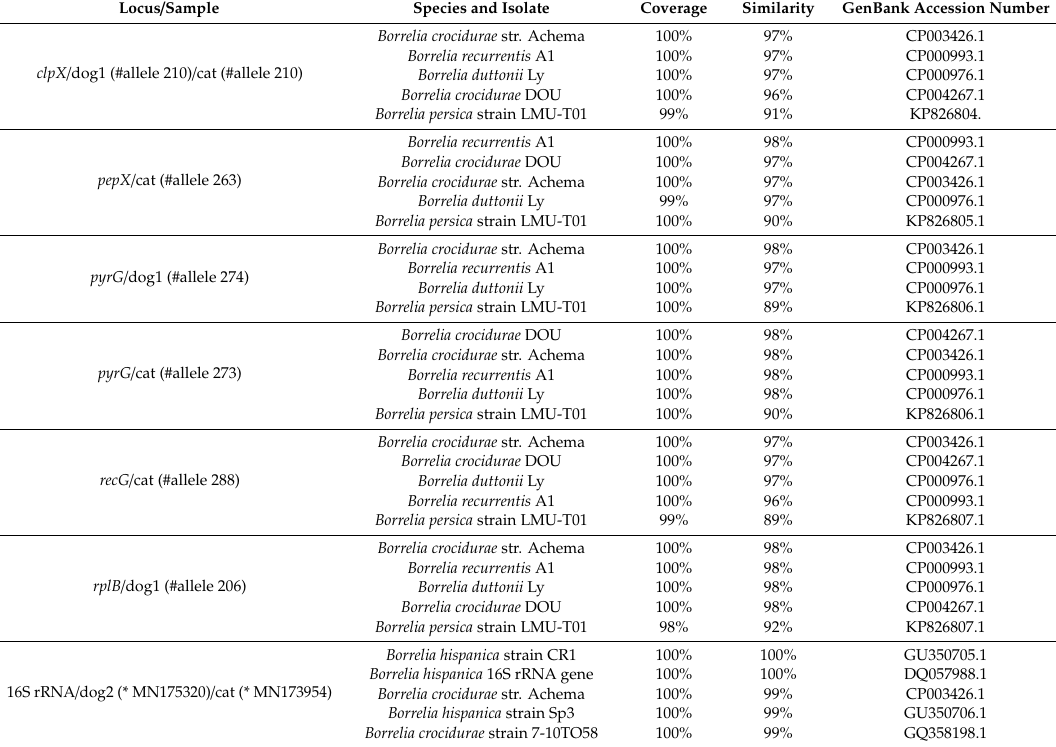
Table 3. Allele numbers, GenBank accession numbers, and Basic Local Alignment Search Tool (BLAST) hits in